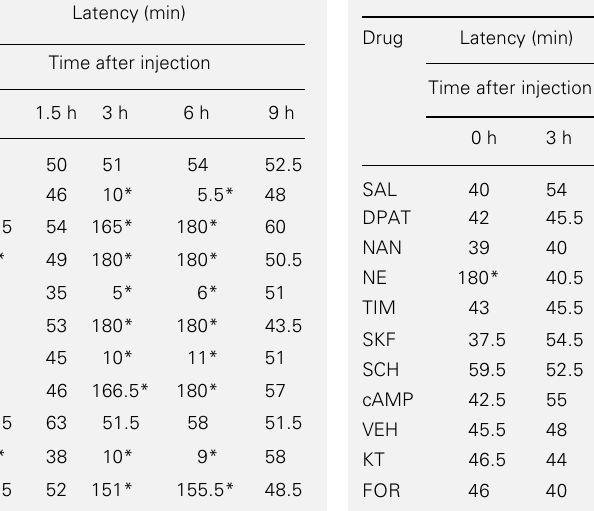
Table 2 - Median test session latency in groups infused bi- laterally into the amygdala with the following drugs: 8- OH-DPAT (DPAT), NAN-190 (NAN), norepinephrine (NE), timolol (TIM), SKF38393 (SKF), SCH23390 (SCH), 8-Br- cAMP (cAMP), KT5720 (KT), forskolin (FOR), vehicle (VEH) and saline